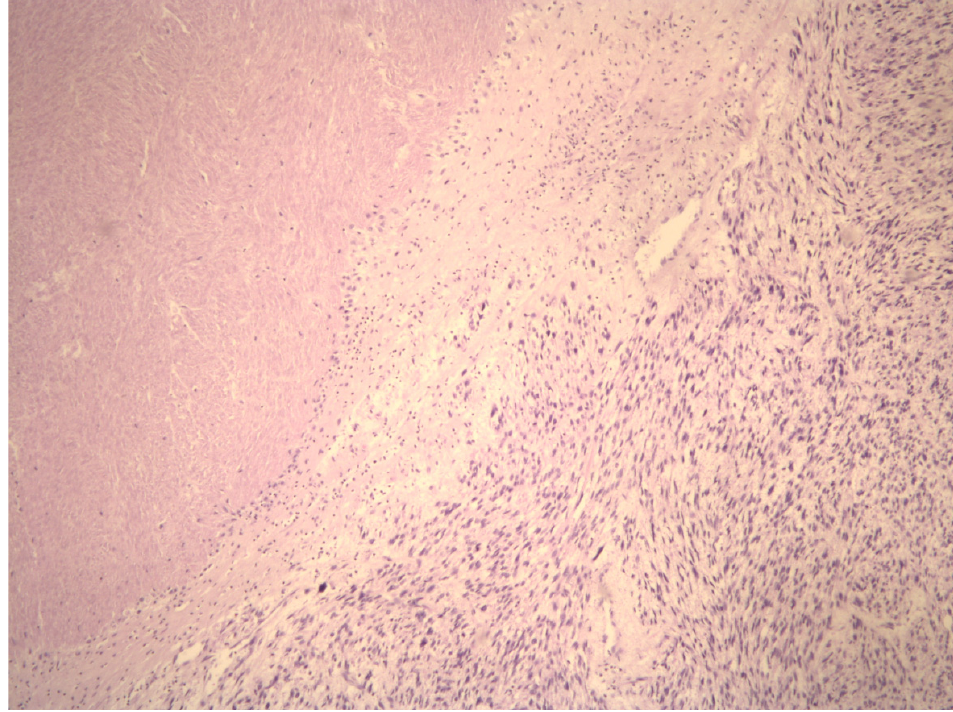
Figure 1. Aview of the pathohistological preparation of LMS cells (magnification at 5×) showing the coagulative necrosis of LMS cells. This highlights the demarcation of area of viable and necrotic LMS cells.